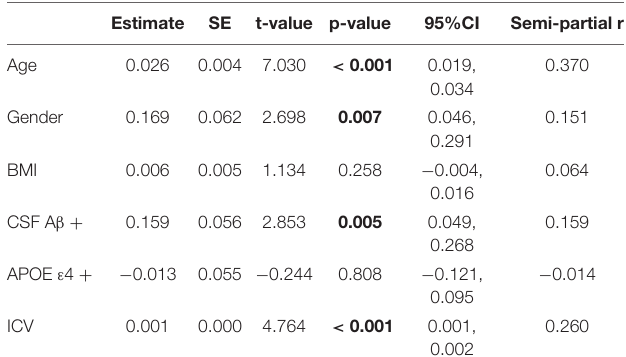
TABLE 2 | Final Multiple Linear Regression Models for CU Older Adults. Systolic Blood Pressure Estimate SE t-value